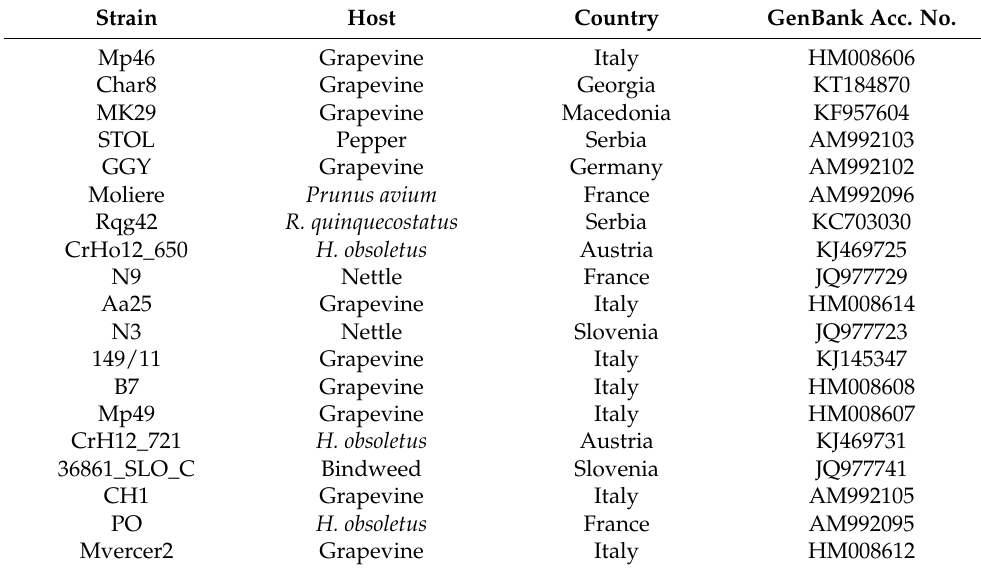
Table 1. Sequences retrieved from the GenBank of vmp1 gene variants used in the phylogenetic